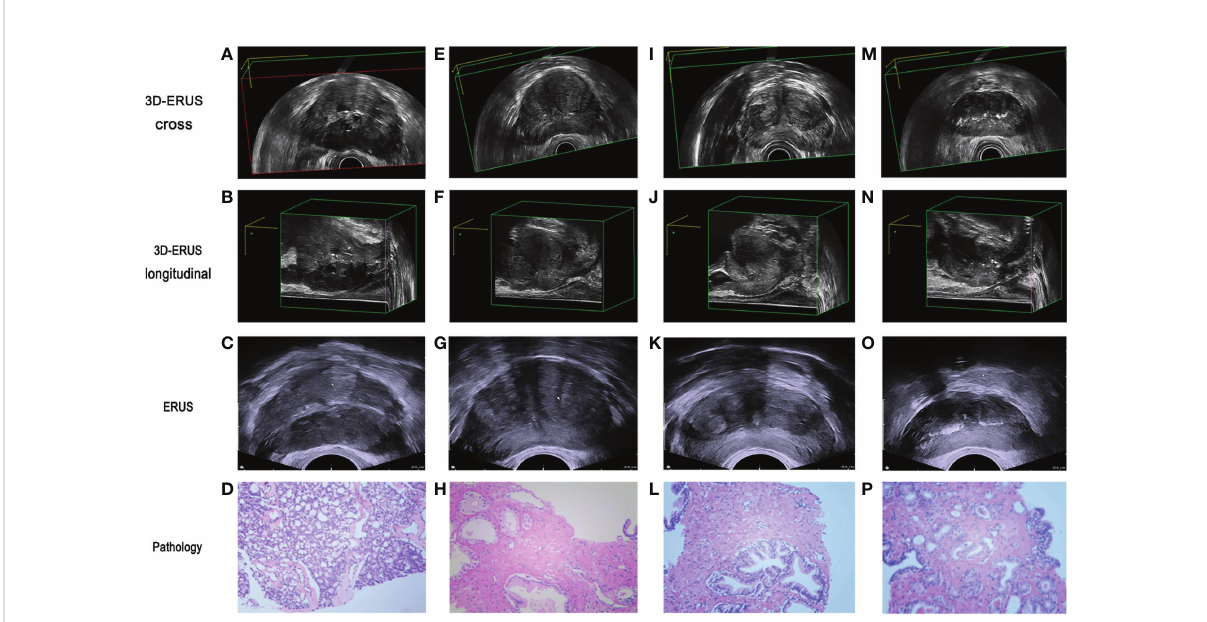
FIGURE 4 The comparison of prostate cancer and non prostate cancer diagnosis by different diagnostic methods. (A, B) 3D-TRUS showed prostate cancer in cross and longitudinal section; (C) TRUS showed prostate cancer; (D) pathological diagnosis of biopsy samples showed prostate cancer. (E – F) 3D-TRUS showed prostate cancer in cross and longitudinal section; (G) TRUS showed prostate cancer; (H) pathological diagnosis of biopsy samples showed non prostate cancer. (I – J) 3D-TRUS showed non prostate cancer in cross and longitudinal section; (K) TRUS showed prostate cancer; (L) pathological diagnosis of biopsy samples showed non prostate cancer. (M – N) 3D-TRUS showed non prostate cancer in cross and longitudinal section; (O) TRUS showed non prostate cancer; (P) pathological diagnosis of biopsy samples showed prostate